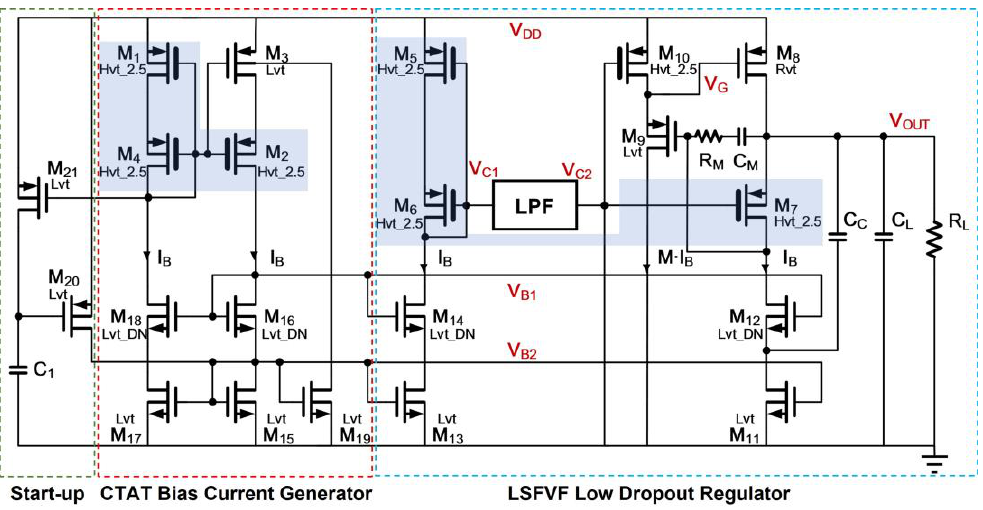
Figure 6. Proposed PSR Enhancer.